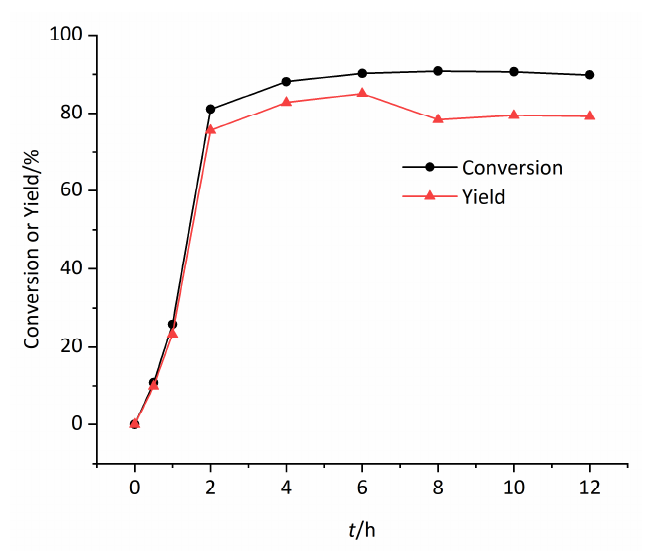
Figure 6. The conversion of styrene or yield of epoxidation with reaction time t .